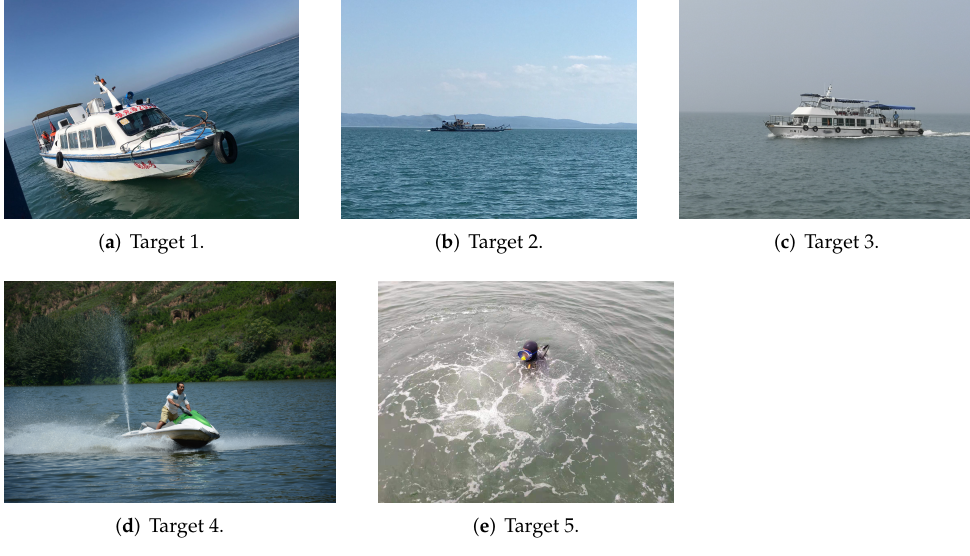
Figure 7. Five types of different